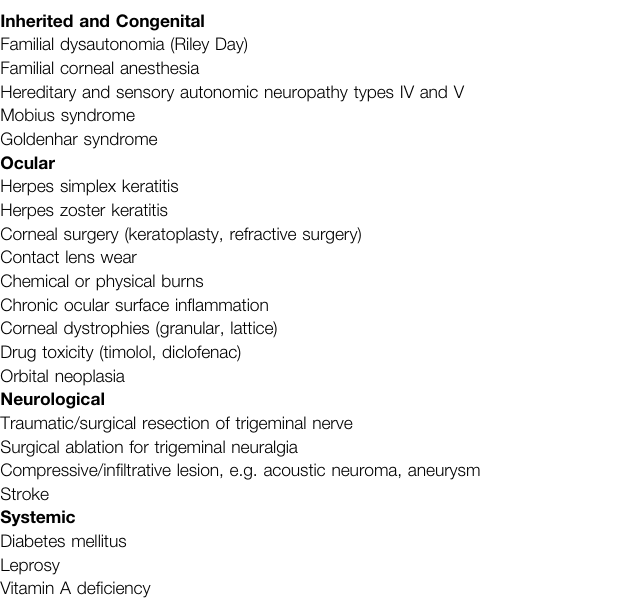
TABLE 1 | Classi fi ed causes of neurotrophic